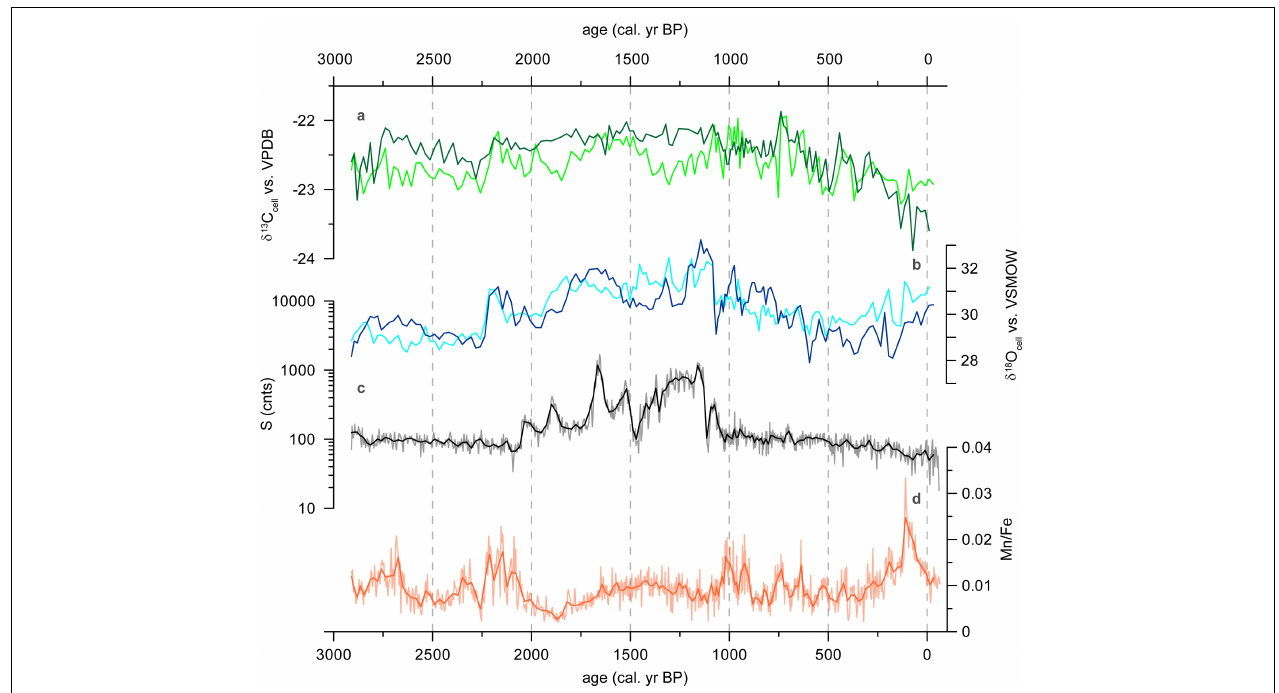
vs. VPDB) for fraction 200–1000 µ m (light green) and > 1000 µ m (dark green), (b) δ 18 O cell ( FIGURE 9 | Results of core Tuz-694. (a) δ 13 C cell ( fraction 200–1000 µ m (dark blue) and fraction > 1000 µ m (light blue), (c) Sulfur content (black: 5 pt. average, log10-scale), (d) Mn/Fe ratio (orange: 5 pt. average). (cid:104)